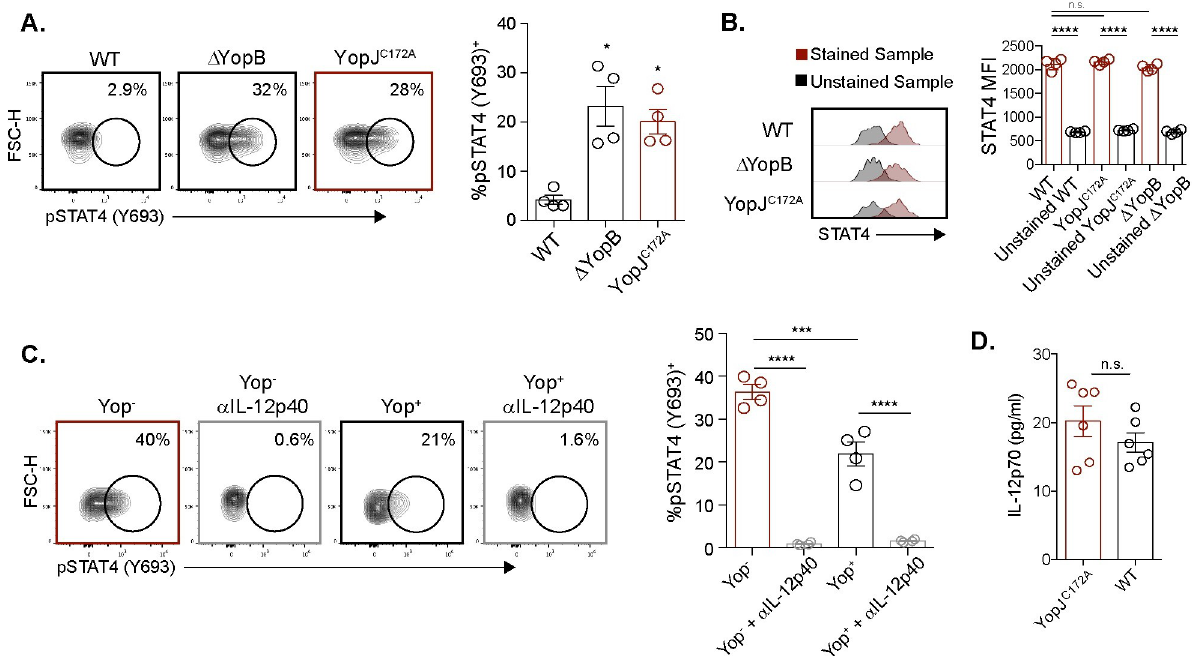
Fig 5. YopJ inhibits IL-12p40 mediated STAT4 phosphorylation. ( A ) MLN cell suspensions from L . monocytogenes infected mice were stimulated with 10 MOI of WT, YopJ C172A , or Δ YopB Y . pseudotuberculosis for 6 hours. Antibiotics were given 2 hours after stimulation. V γ 1.1/2 - CD44 hi CD27 - γδ T cells were analyzed for pSTAT4 after stimulation. Representative contour plots are displayed. The graph depicts mean ± SEM and represents at least two independent experiments with 2–4 mice per group. ( B ) The same experimental setup was used as in ( A ), but V γ 1.1/2 - CD44 hi CD27 - γδ T cells were analyzed for STAT4 protein after stimulation. Representative plots for mean fluorescent intensity (MFI) are displayed. The graph depicts mean ± SEM and represents two independent experiments with 2 mice per group. ( C ) MLN suspensions from L . monocytogenes infected mice were either treated or untreated with IL-12/23p40 neutralizing antibody prior to stimulation with 1 MOI of WT Yptb - β la for 6 hours. Antibiotics were given 2 hours post-stimulation. V γ 1.1/2 - CD44 hi CD27 - γδ T cells were analyzed for pSTAT4 after stimulation. Representative contour plots are displayed. The graph depicts mean ± SEM and represents at least two independent experiments with 2–4 mice per group. ( D ) MLN cell suspensions from L . monocytogenes infected mice were stimulated with 10 MOI of WT or YopJ C172A Y . pseudotuberculosis for 24 hours. Antibiotics were given 2 hours after stimulation. Supernatants were collected 24 hours post stimulation and IL-12p70 concentration was determined via ELISA. ���� p < 0.0001, ��� p < 0.001, �� p < 0.01, and � p < 0.05. A repeated measures one-way ANOVA was used for ( A - C ). Comparisons were performed to WT Y . pseudotuberculosis in ( A ) and as depicted in ( B - D